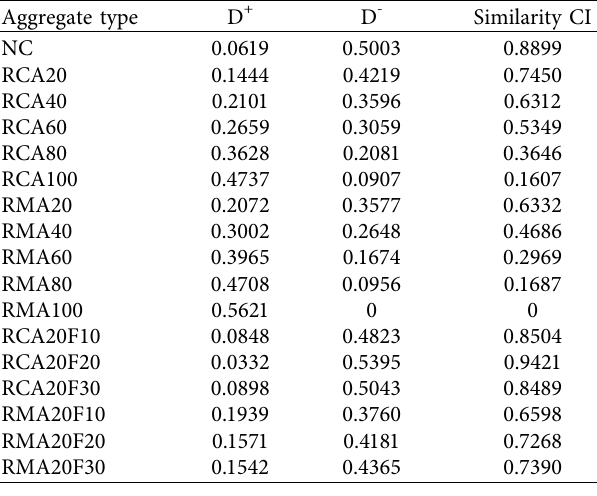
Table 8: Sorting index values for different types of recycled ag- gregate materials.